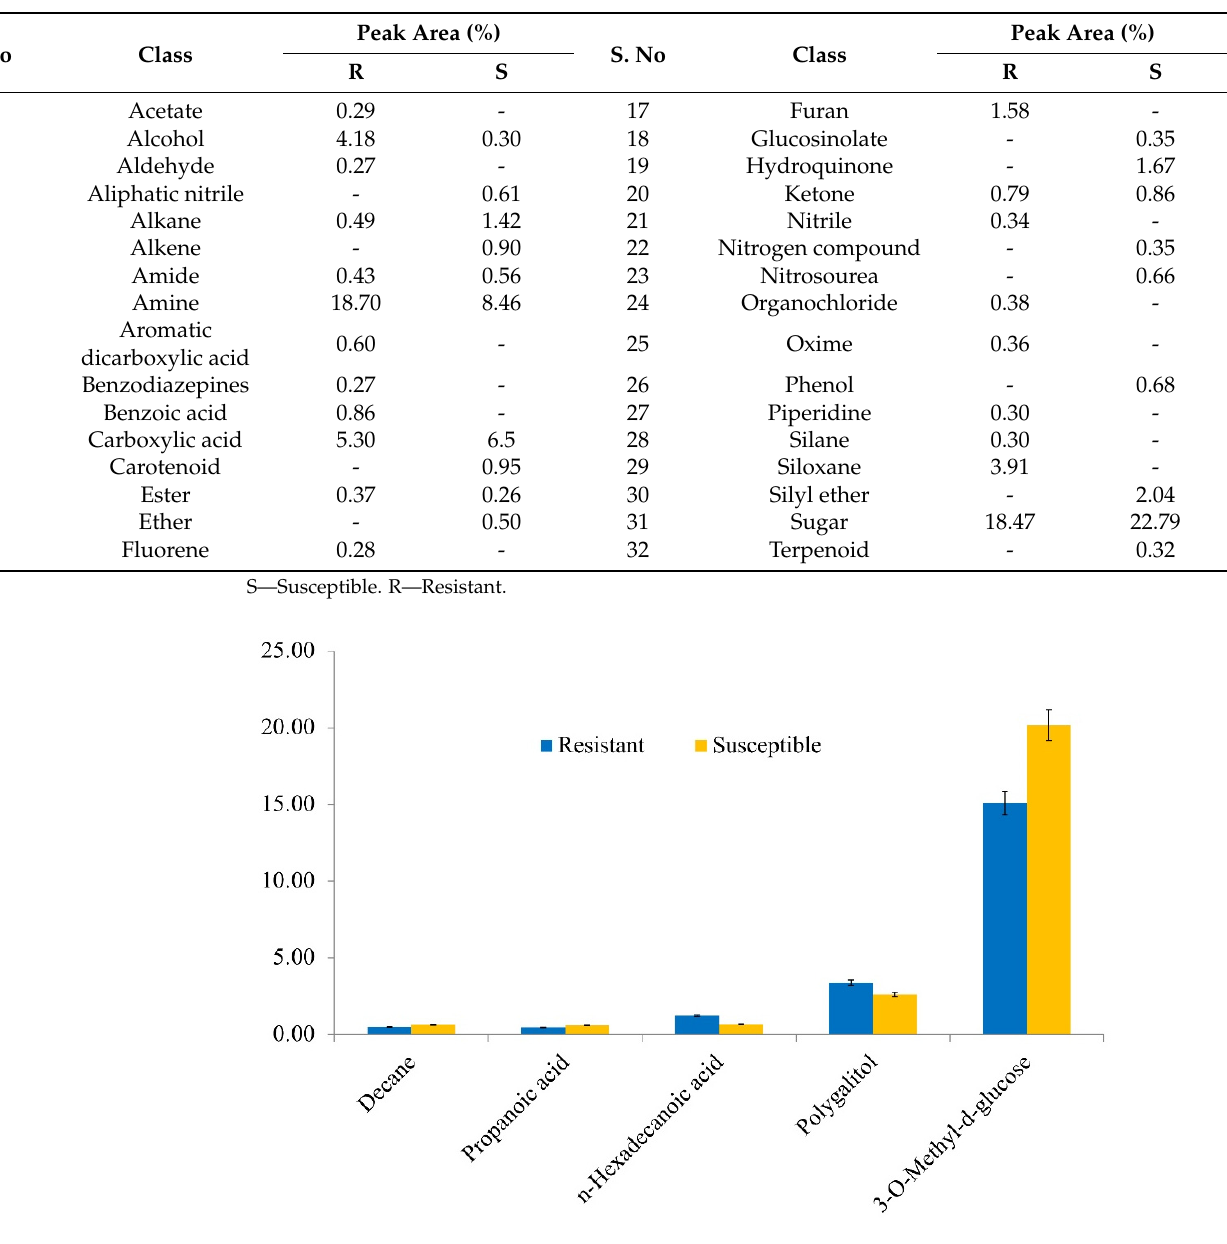
Table 3. List of differentially expressed bio-molecules classes in horse gram with respect to powdery mildew infection.